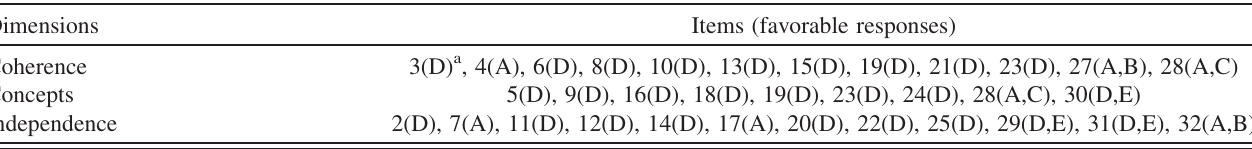
a Abbreviations: A, agree for 2-25 items; D, disagree for 2-25 items. For 27-32 items, A, B, C, D, and E indicate item alternative choices.